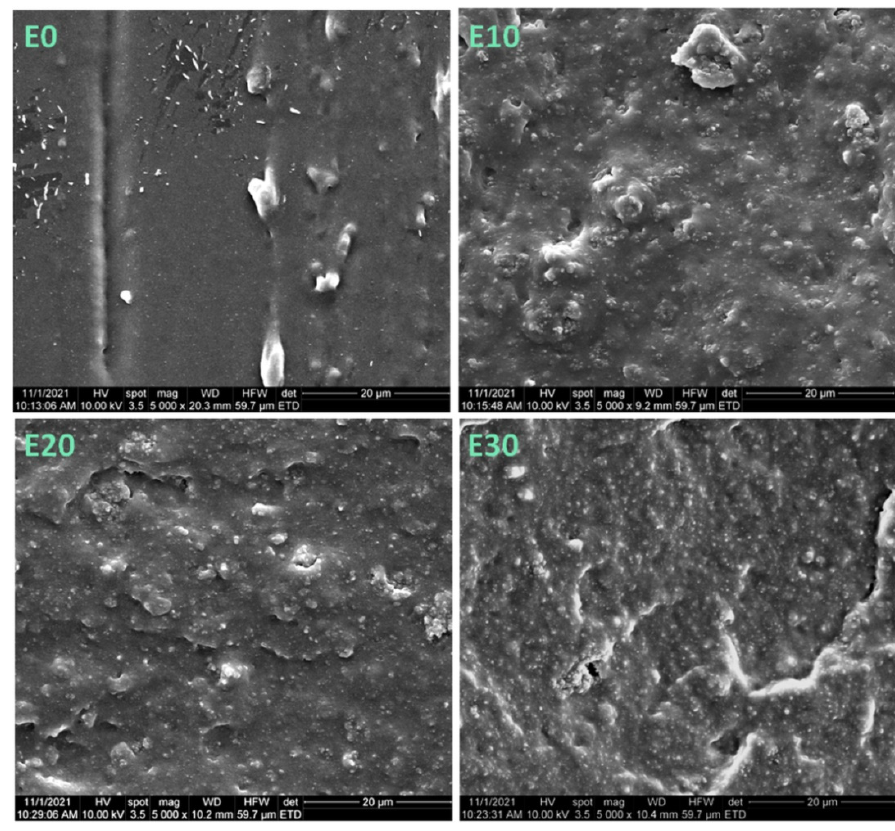
Figure 2. SEM images of the cryo-fractured sections of E0, E10, E20 and E30 nanocomposites.